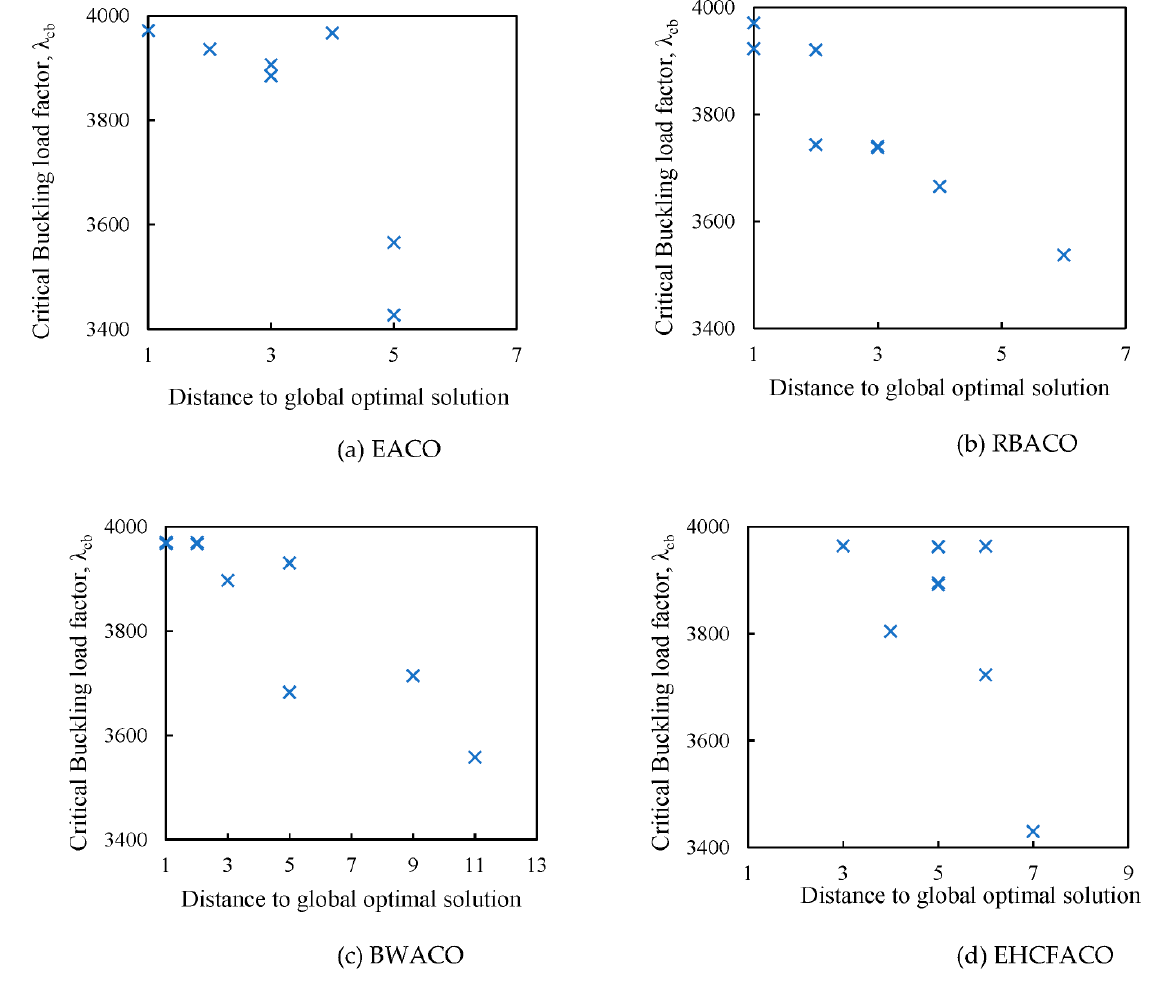
Figure 12. Fitness vs. distance to global optimal solution of ACO algorithms.